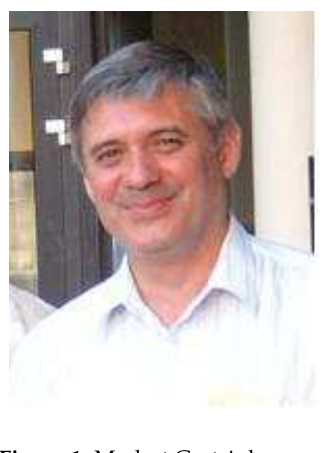
Figure 1. Modest Gertsiuk.